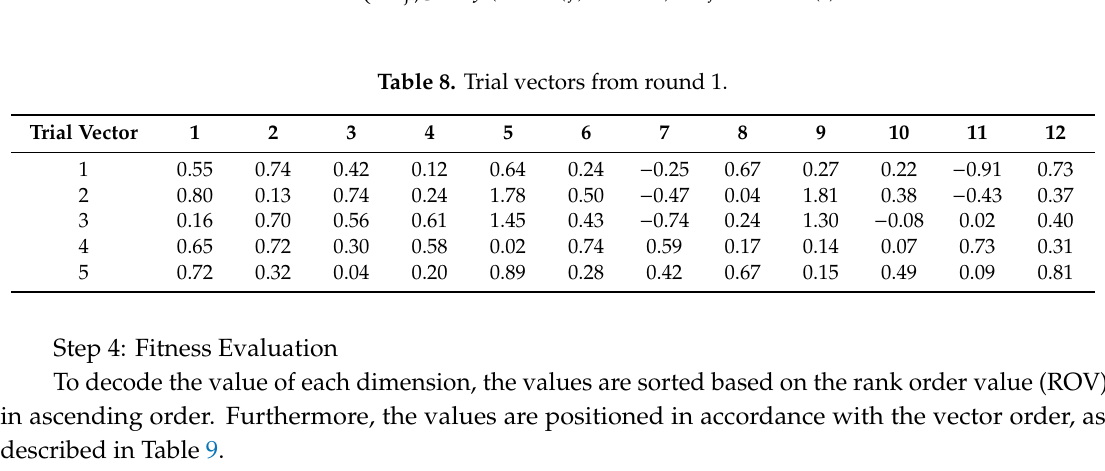
Table 9. Results of decoding.